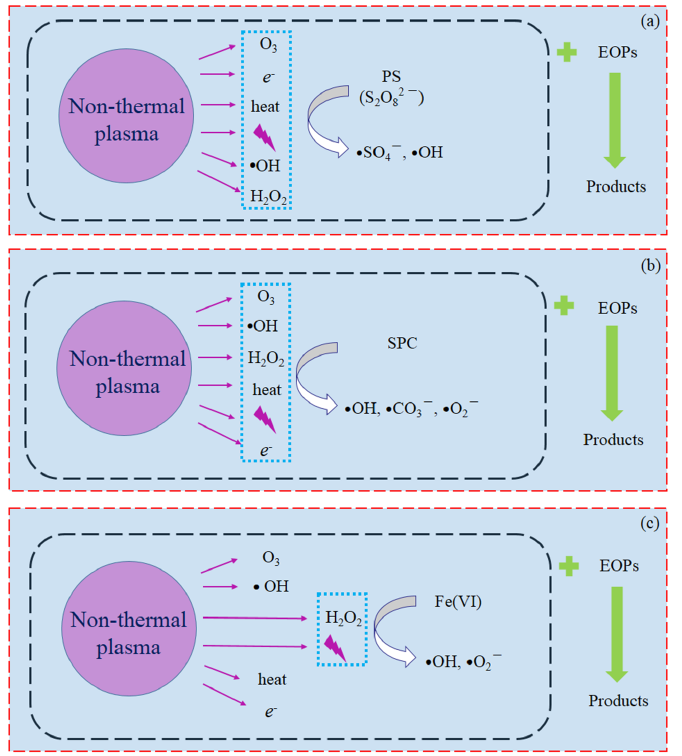
Figure 6. Possible degradation mechanisms of EOPs combined with different oxidants: ( a ) PS, ( b ) SPC, ( c ) Fe (VI).